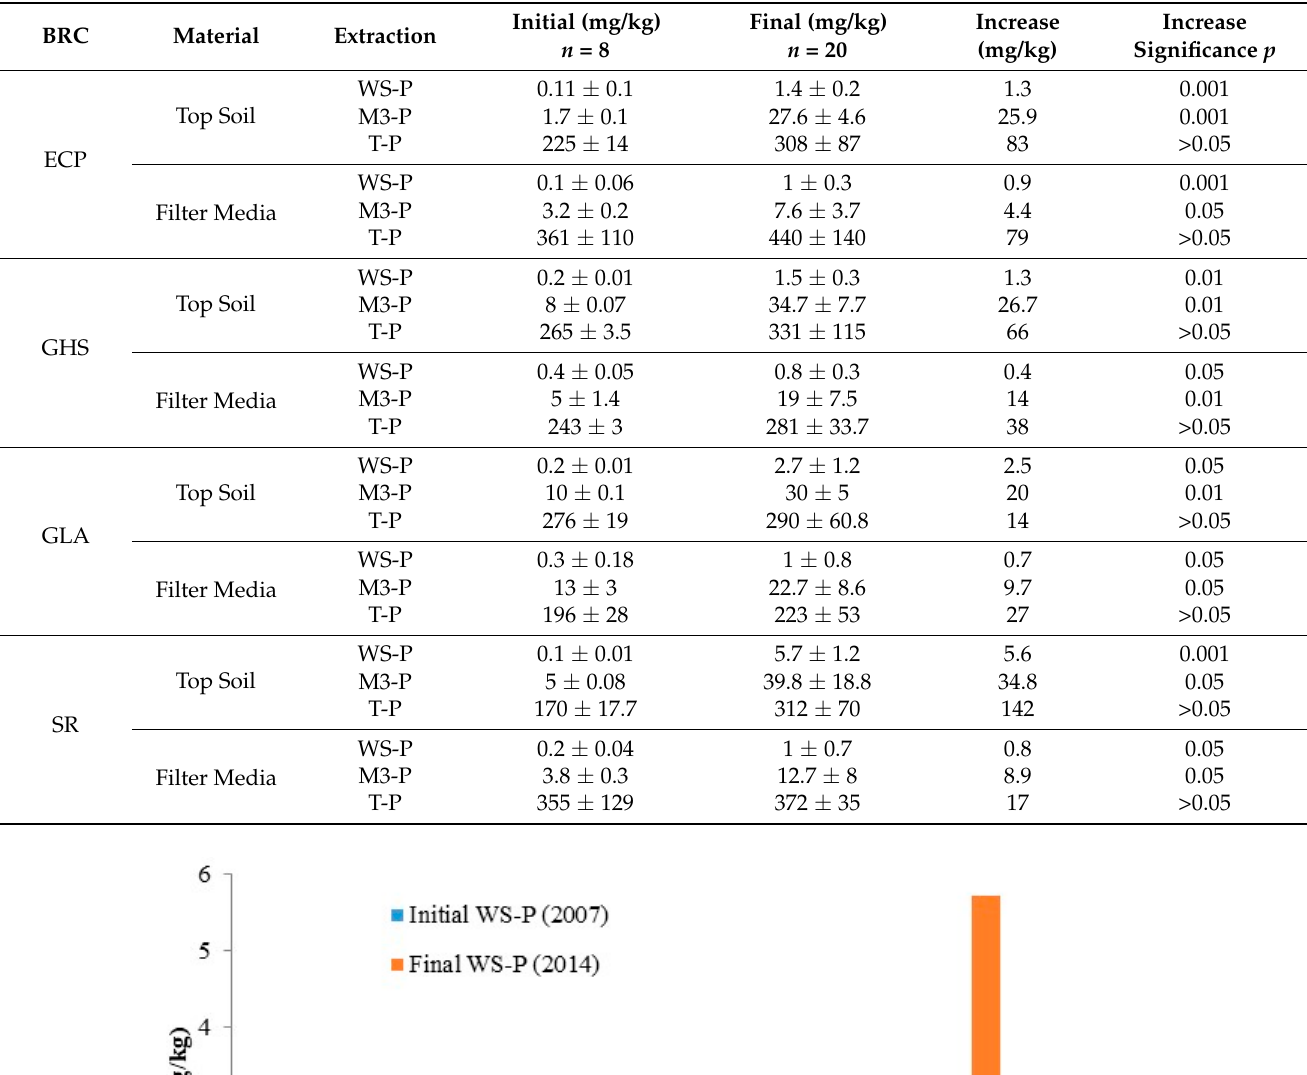
Table 5. Mean and standard deviation of initial and final phosphorus concentrations by extraction method, and Tukey test significance of phosphorus increase in BRCs before and after seven years of operation ( p ).